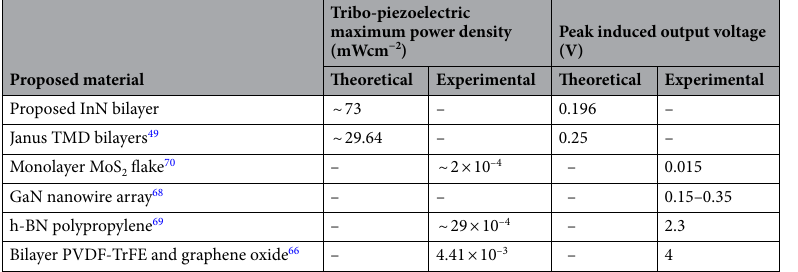
Table 1. Comparison of the maximum power density and induced voltage obtained from the proposed tribo- piezoelectric nanogenerator structure with previously investigated